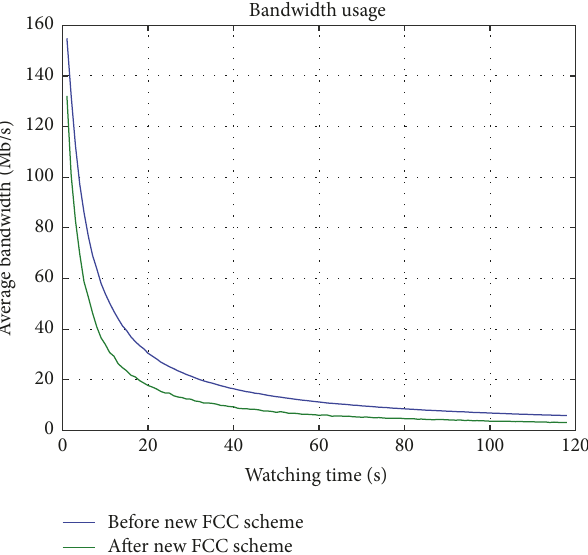
Figure 12: Bandwidth behavior in terms of the number of channels.